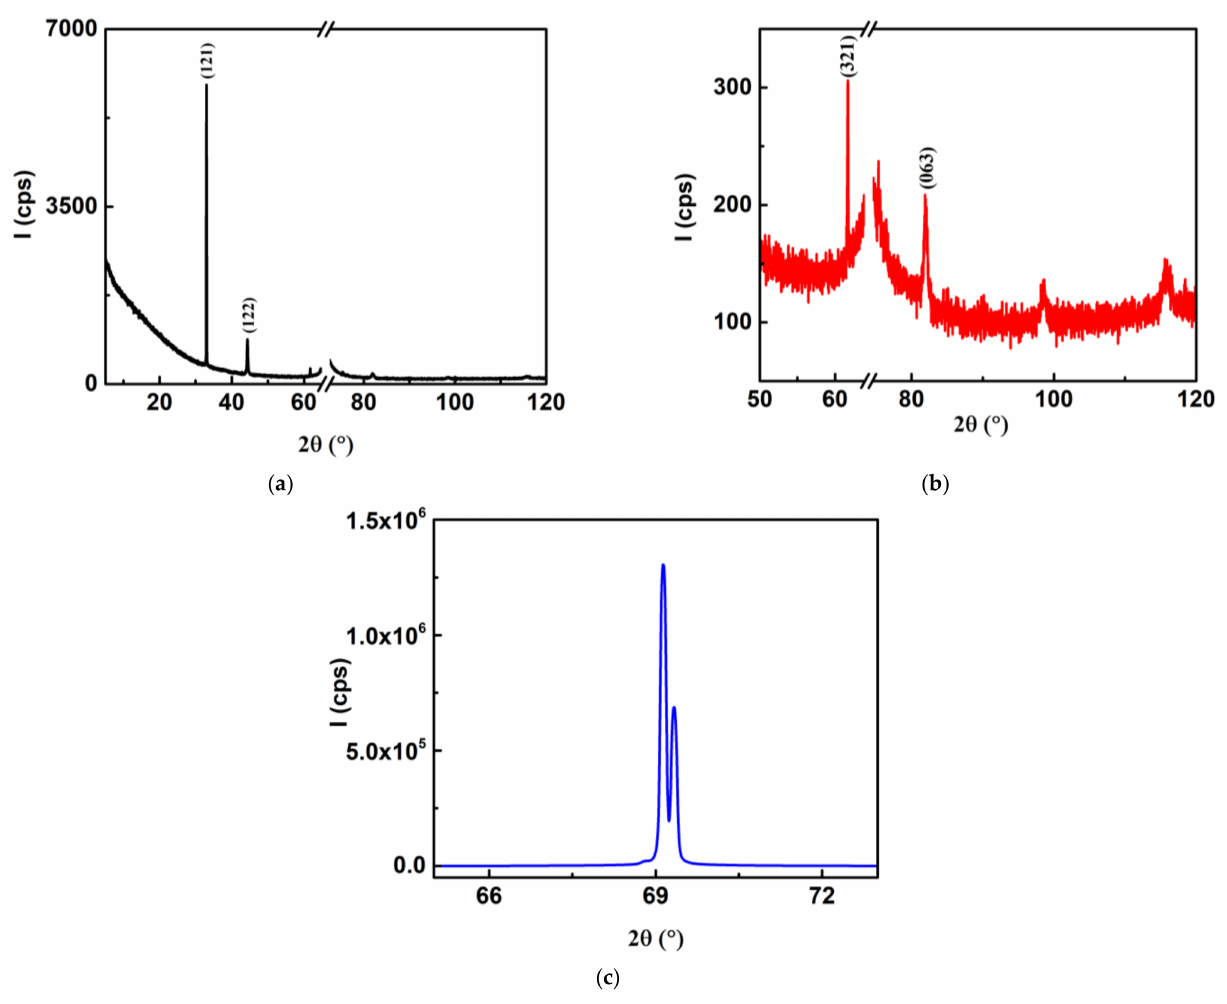
Figure 7. ( a ) XRD Diffractogram of TiO 2 layer (sample S2) in the range 5–120 ◦ , showing the specific peaks of brookite, ( b ) zoom in, ( c ) the peak of the Si (100) substrate.